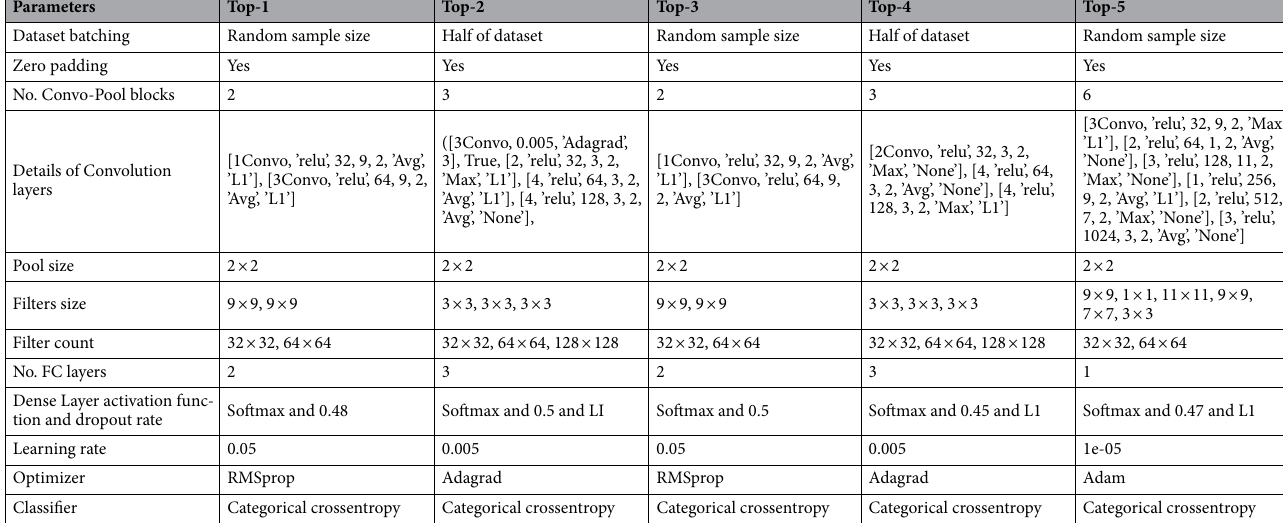
Table 9. Comparison of parameters for the best five (5) initial neural network configurations (solutions) generated for the search space.